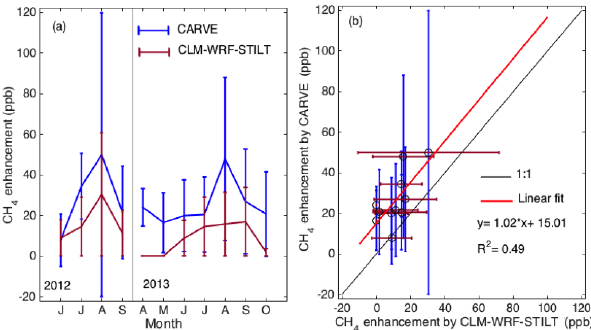
Figure 5. The monthly mean atmospheric mole fraction enhance- ments in CH 4 estimated by WRF-STILT-CLM4.5 and CARVE measurements. (a) Observed and simulated monthly CH 4 mole fraction enhancements in 2012 and 2013; (b) linear regression of measured versus modeled CH 4 mole fraction enhancements. The error bars are standard deviation of monthly